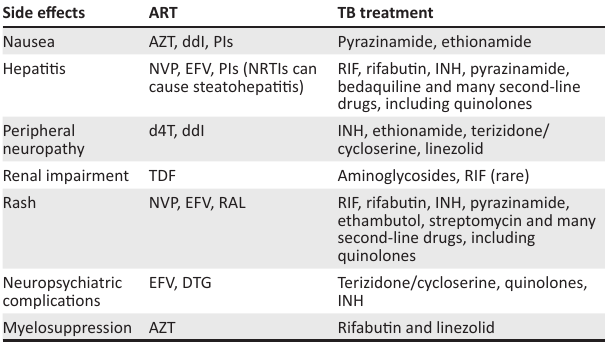
TABLE 10: Shared side effects of antiretroviral therapy and tuberculosis treatment. Side